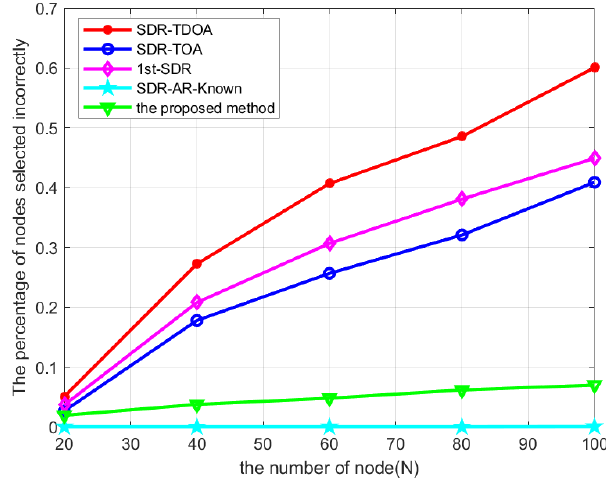
Figure 12. Analysis of optimal selection accuracy of detection equipment.